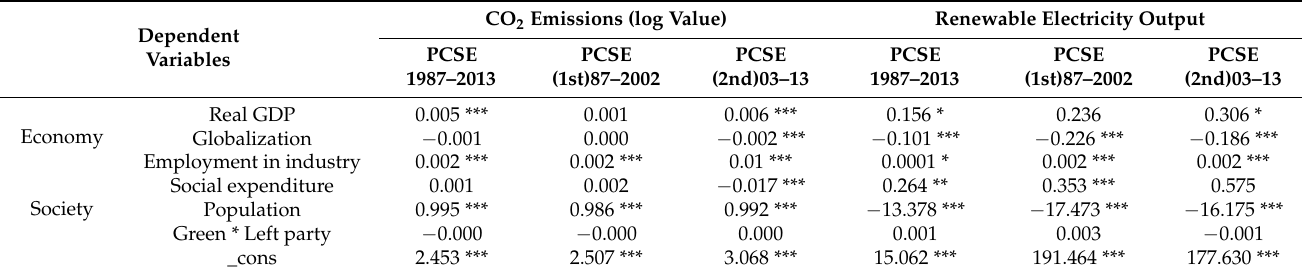
Table 3. Determinants of CO 2 emissions and renewable electricity